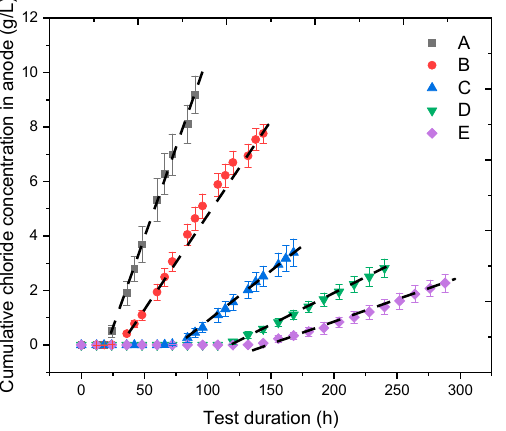
Figure 4. The relationship between w/c and steady state diffusion starting time point.